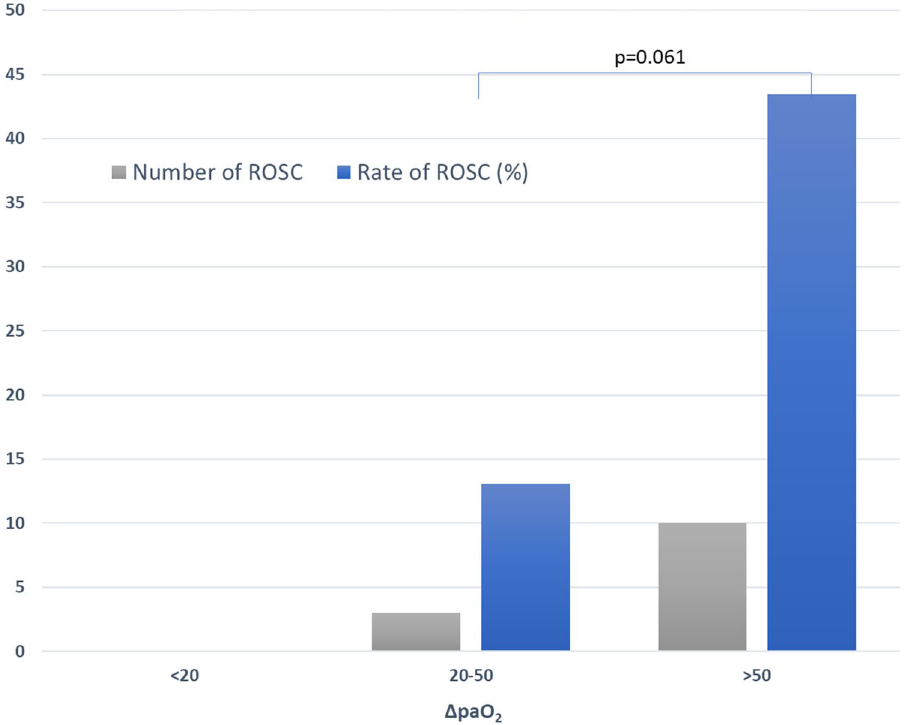
Figure 2. Rates of sustained return of spontaneous circulation (ROSC) with respect to the delta values of arterial pO 2 level. The delta values were divided into three groups. Cutoff values for each group were chosen arbitrarily. Note that there was no sustained ROSC case in the first group (ΔpaO 2 < 20 mmHg). pO 2 partial pressure of